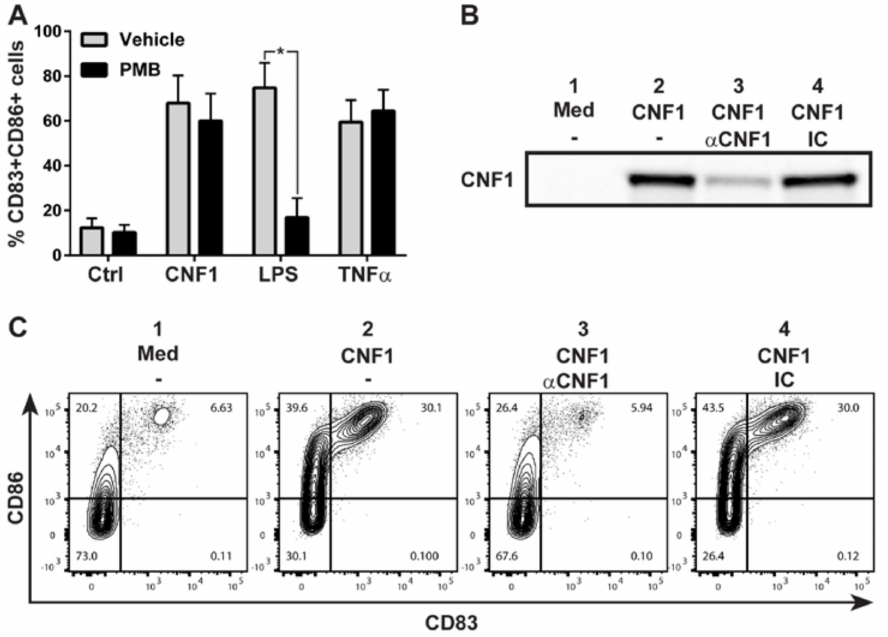
Figure 2. CNF1-induced moDC maturation is not driven by endotoxin or other putative contaminants in the toxin preparation. ( A ) Culture media alone (Ctrl) or culture media containing 0.1 nM CNF1, 50 ng/mL lipopolysaccharide (LPS) or 50 ng/mL tumor necrosis factor alpha (TNF α ) was pre-incubated for 30 min at room temperature with 5 µ g/mL Polymyxin B (PMB) or vehicle (endotoxin-free water).